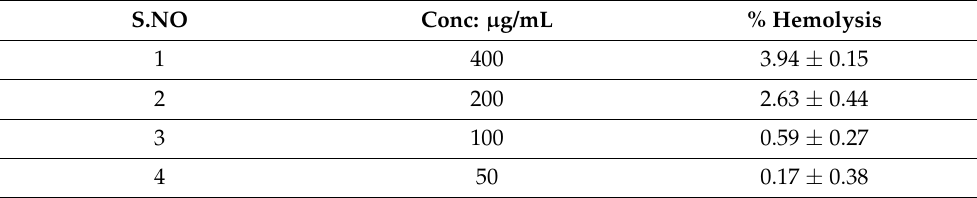
Table 8. Percentage hemolysis of FeNPs.